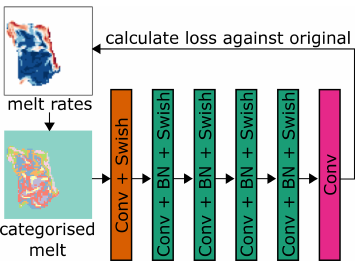
Figure C1. Schematic for the DAE net architecture used in this study. A melt rate field, as calculated by NEMO for a given input geometry, is converted to a matrix of discrete melt labels. These la- belled melt rates that served as the input to the network go through a series of convolution, batch normalisation, and swish layers, lead- ing to an output. The loss of this output is calculated against the original melt rate field to train the network to recover a continuous melt rate field from discrete melt rate